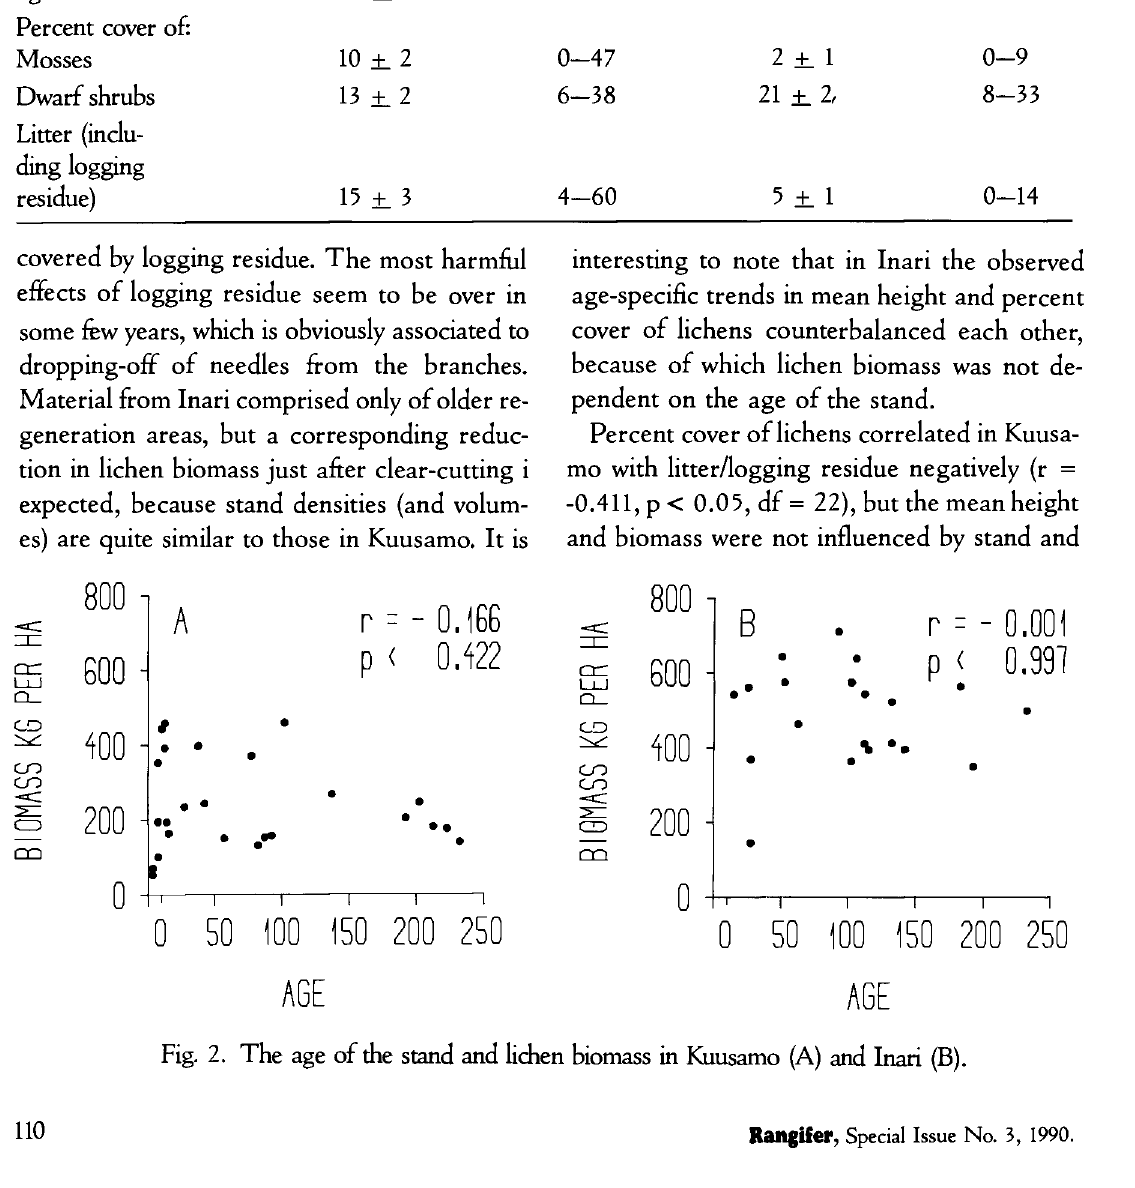
Fig. 2. The age of the stand and lichen biomass in Kuusamo (A) and Inari